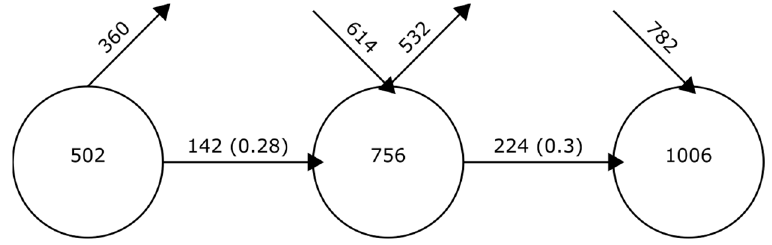
Figure 3. Continuity of keywords between adjacent intervals.